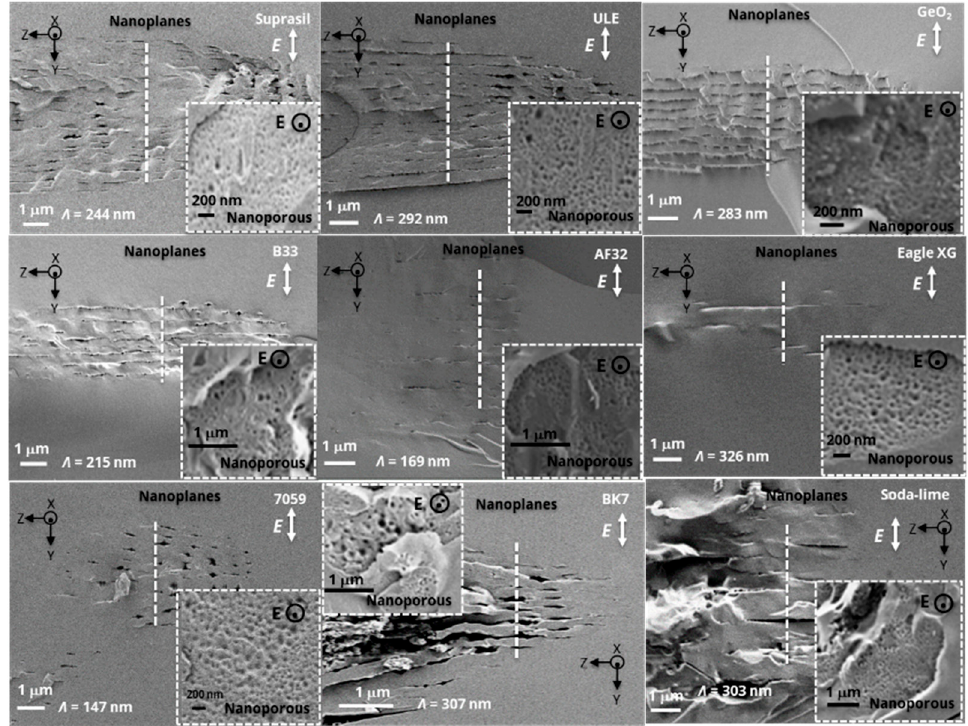
Figure 3. The SEM secondary electron micrographs of laser track cross-sections written in different oxide glasses (Suprasil, ULE, GeO 2 , B33, AF32, Eagle XG, 7059, BK7, and soda-lime). The polarization direction ( E ) was perpendicular or parallel (insert) to the writing direction. Experimental conditions: 1030 nm, 800 fs, 0.6 NA, pulses densities f / v = 10 3 pulse/µm (ULE, GeO 2 , AF32, B33), f / v = 10 4 pulse/µm (soda-lime, Eagle XG), f / v = 10 5 pulse/µm (50 kHz for 7059 and 25 kHz for BK7), 250 fs, f / v = 500 pulse/µm (Suprasil), Xx writing configuration. The pulse energy was chosen to fall within the Type II regime.